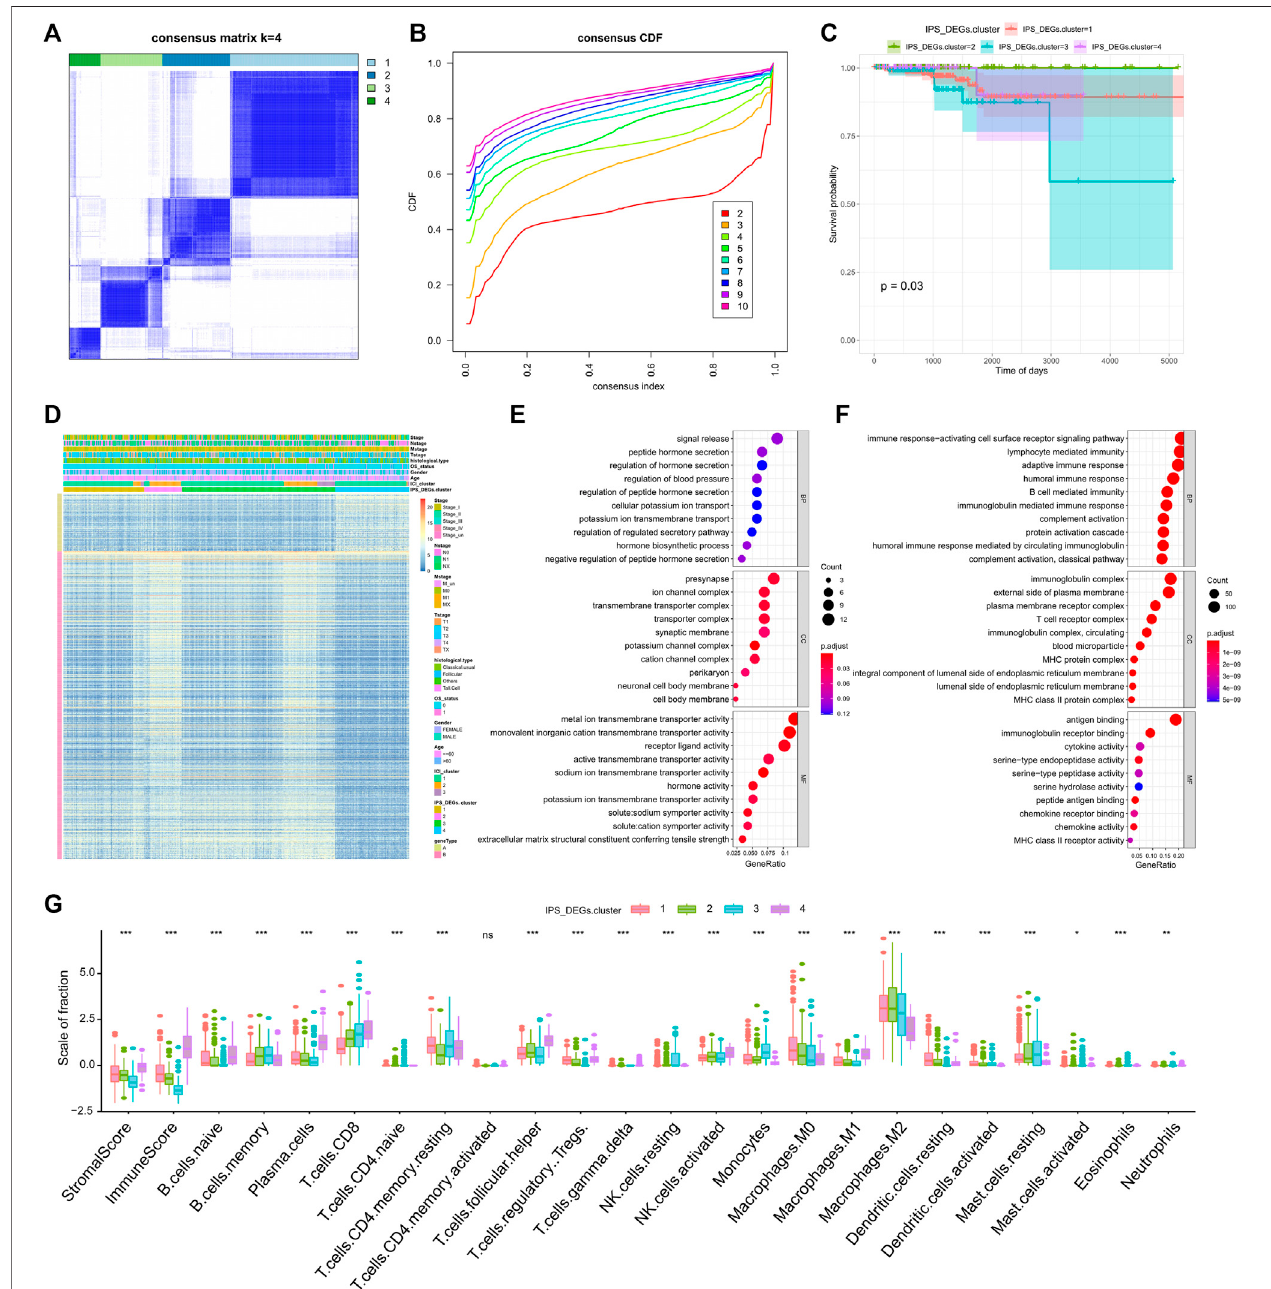
FIGURE 2 | Consistent clustering of differentially expressed genes related to tumor immune antigenicity. (A) Clustering results when k (cid:1) 4; (B) CDF curve distribution ofconsistent clustering; (C) Survivalcurveofmolecularsubtypes when k (cid:1) 4; (D) Heat map ofimmunegene subtypes; (E) Functional enrichment ofimmune genesubtyperelatedfeaturesAgene; (F) FunctionalenrichmentofimmunegenesubtyperelatedfeaturesBgene; (G) Differencesinin fi ltrationcharacteristicsofimmune cells between immune gene subtypes.